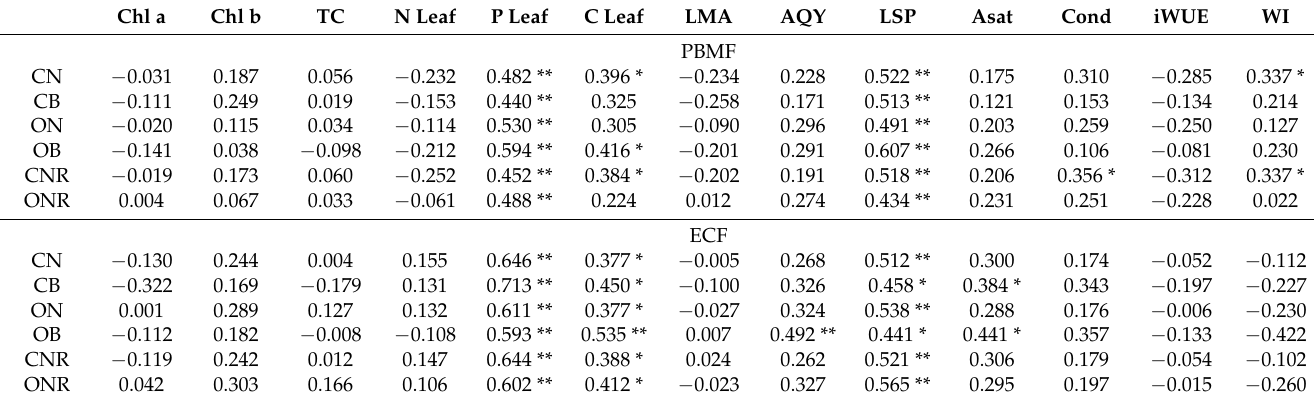
Table 5. Correlation coefficients of growth properties with leaf indicators at each forest type.